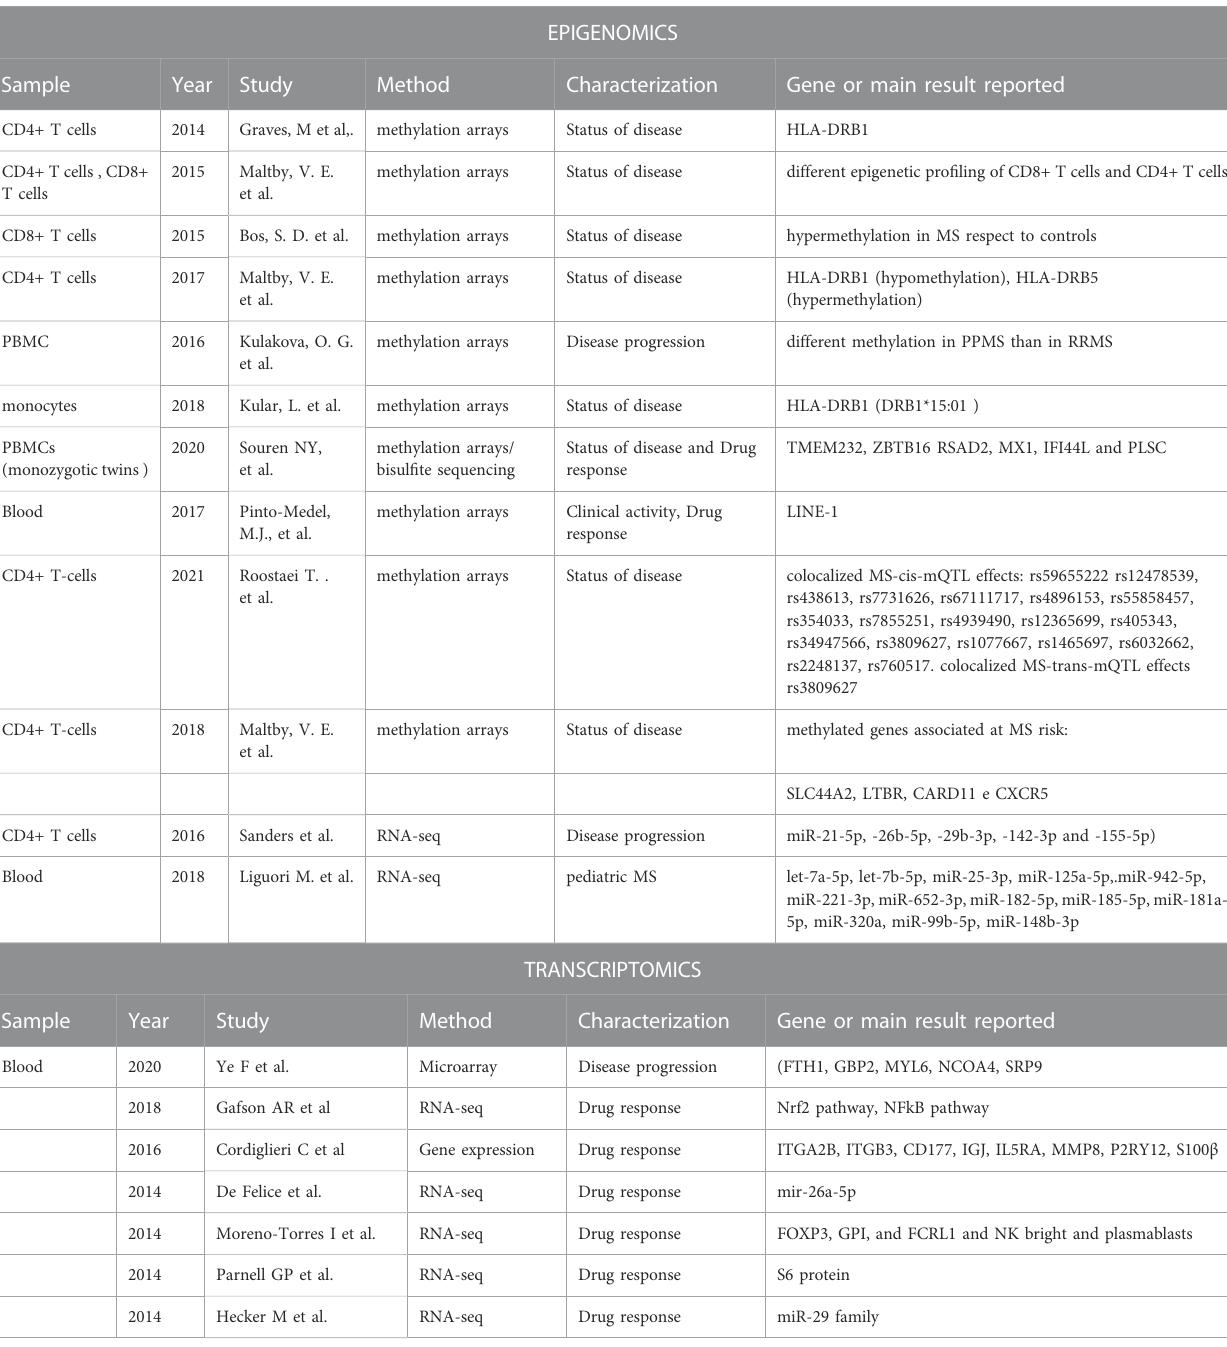
TABLE 3 Main results for epigenomics and